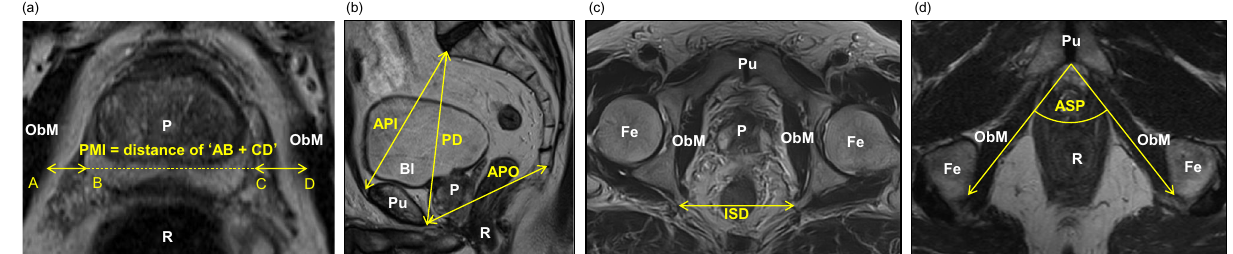
Figure 1. Definition of parameters in MRI measurements. ( a ) Axial section of MRI on T2 showing the maximum area of the prostate. A dashed-yellow line ‘BC’ indicates the maximum length of the width of the prostate at the section showing the maximum area of the prostate. The line is extended where it crosses the lateral edge of the obturator internus muscle. Point A and D were defined as the point crossing the lateral edge of the obturator internus muscle. ‘Prostate-muscle index (PMI)’ was defined as the sum of distance ’AB + CD’ shown in a yellow line with arrowheads. ( b ) Sagittal section of MRI on T2 showing the pelvic cavity. ‘Anteroposterior diameter of the pelvic inlet (API)’, ‘pelvic depth (PD)’, and ‘anteroposterior diameter of the pelvic outlet (APO)’ were defined as the ‘diameter from the sacral promontory to the most superior aspect of the pubic symphysis’ (mm), ‘diameter from the sacral promontory to the most inferior point of the pubic symphysis’ (mm), ‘diameter from the inferior aspect of the pubic symphysis to the tip of the coccyx’ (mm). ( c , d ) Axial section of MRI onT2 showing the measurement of ISD and ASP. ‘Interspinous distance (ISD)’ was defined as ‘the narrowest distance between tips of the ischial spines’ (mm). ‘Angle of the symphysis pubis (ASP)’ was also measured. P: prostate, Fe: femoral bone, Pu: pubic bone, R: rectum, ObM: obturator internus muscle, Bl: